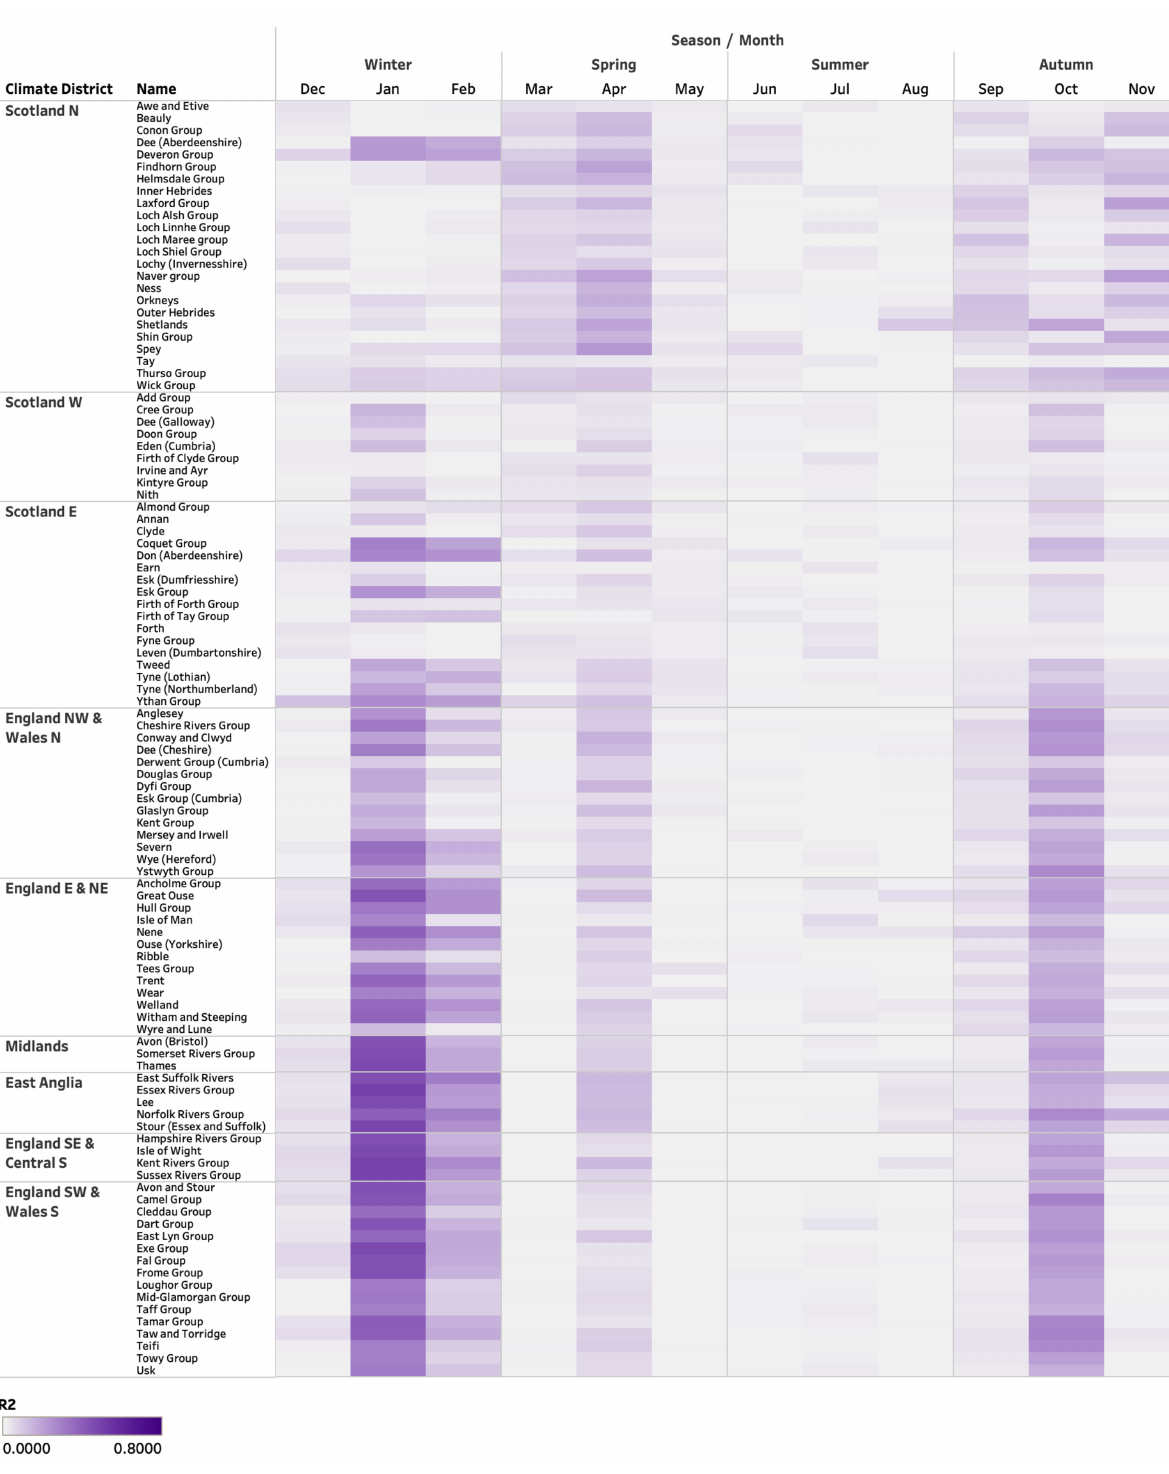
Figure A2. R 2 values of the univariate regression model exploring the relationship between the EAWR index and SPI-1 values across the IHU